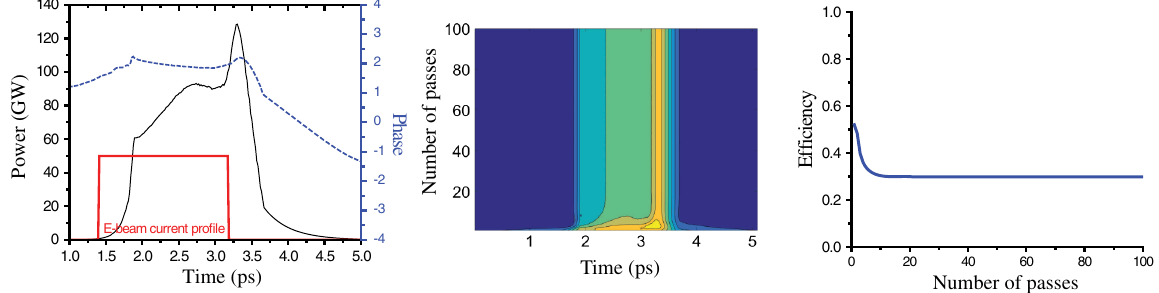
FIG. 12. Left: Final (after 100 passes) pulse envelope along the square electron beam distribution (also shown). Middle: contour plot showing the evolution of the longitudinal profile of the radiation pulse in the oscillator as a function of number of passes. Right: Efficiency of the TESSO oscillator vs. number of passes. For this case the cavity was shortened by 100 fs with respect to the vacuum synchronous condition and the losses were